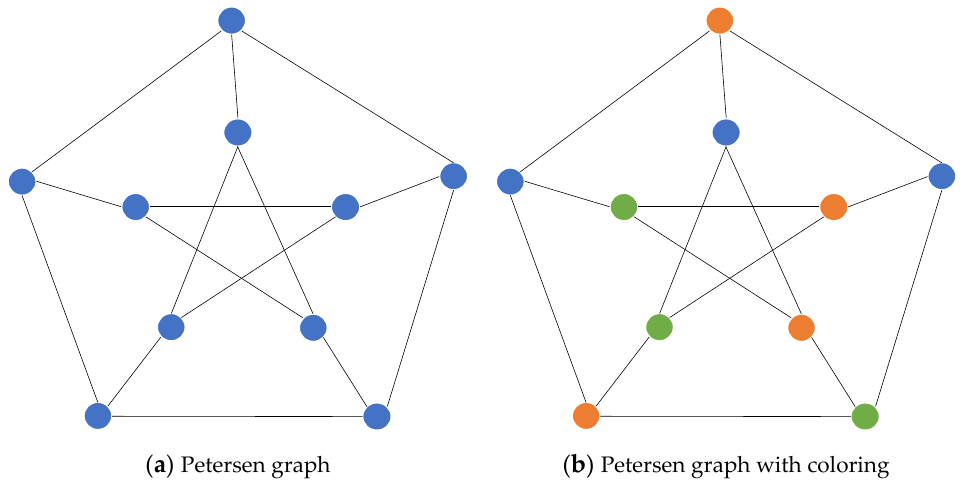
Figure 2. Petersen graphs without and with coloring.